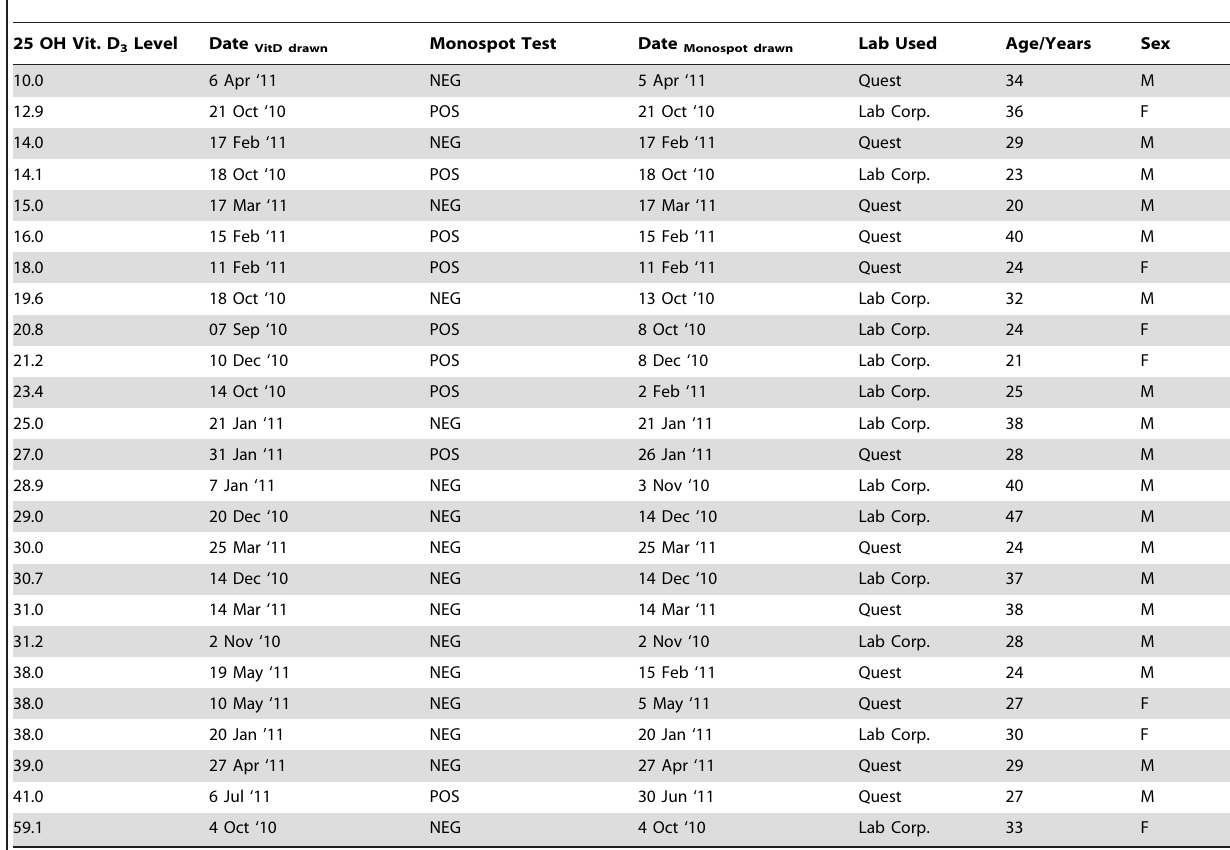
Table 3. Serum 25 OH Vitamin D 3 Levels (ng/ml – lowest to highest) and Monospot Test Results.